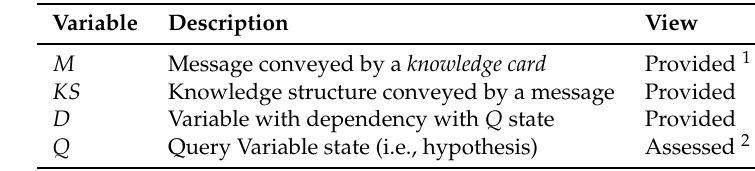
Table 2. MARISA Game